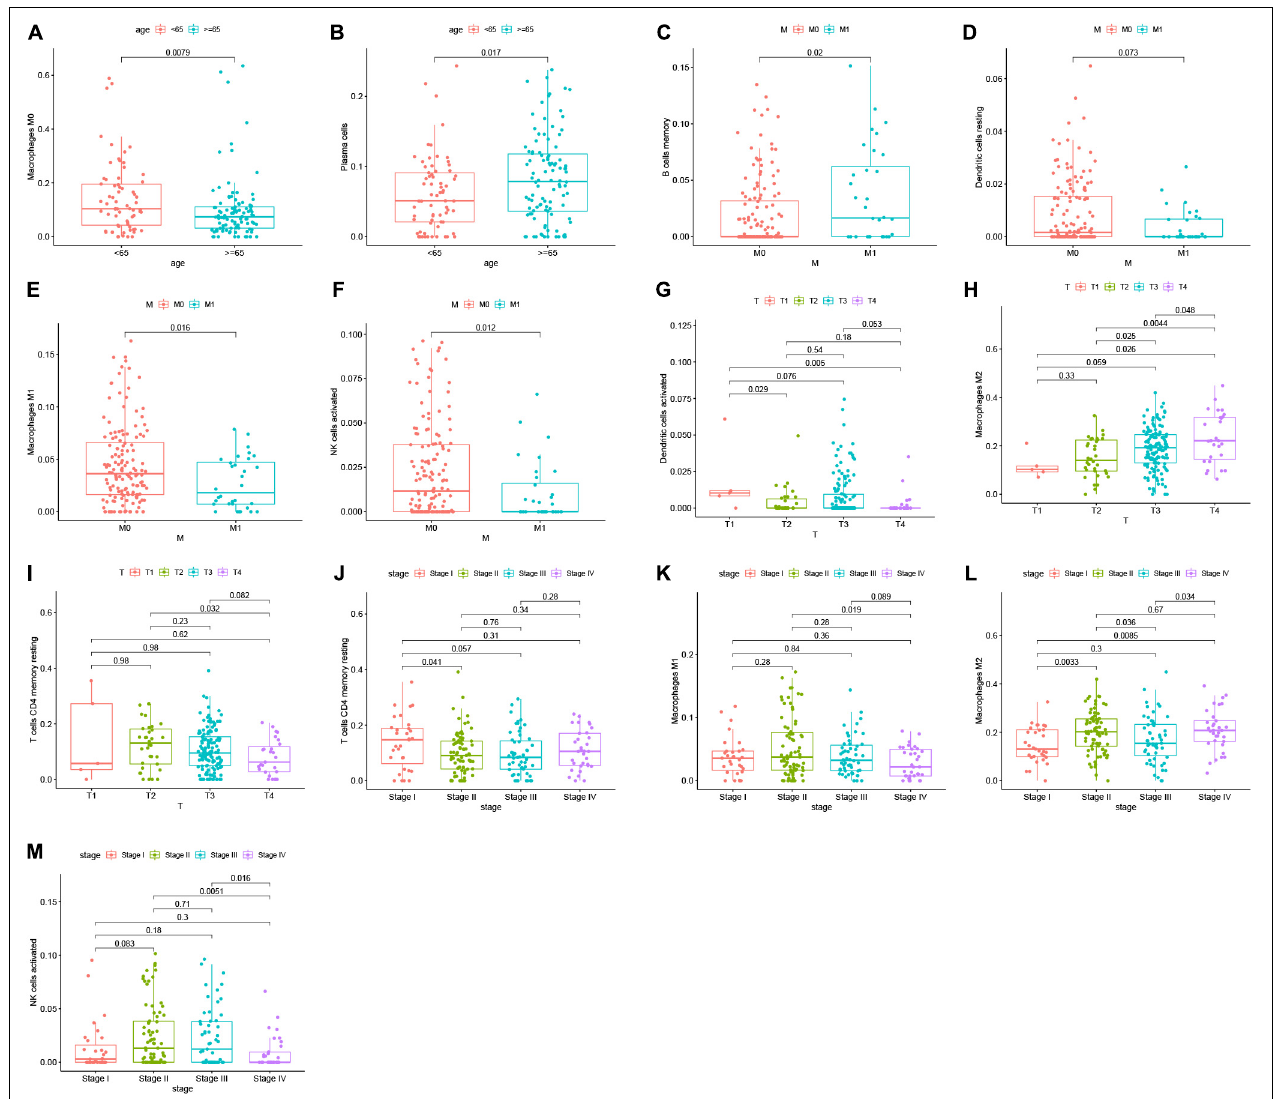
FIGURE 8 | Survival analysis was performed to evaluate the correlation between immune cell infiltration and 152 clinicopathological characteristics. Correlation between immune cell infiltration and clinicopathologic features of patients (A–M) . The three horizontal lines in each picture means mean ±